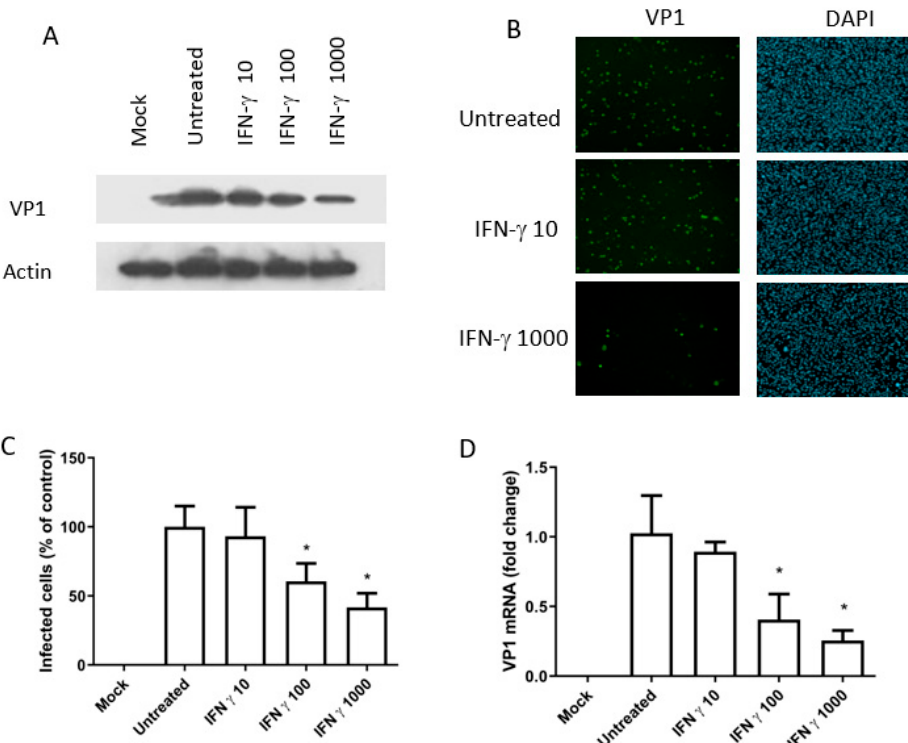
Figure 3. Interferon-gamma has dose-dependent activity against BKPyV in cultures of Caki-1 cells. Caki cells were treated 6 h before BKPyV infection (MOI: 0.5) with 10, 100 or 1000 IU / mL IFN-gamma ( A ) Total cellular proteins were extracted 72 h after infection. VP1 and actin were detected by Western blotting. ( B ) VP1 expression was analyzed using immunofluorescence. The cells were fixed three days post-infection and stained with monoclonal anti-BKPyV VP1 antibody (in green). The DNA was stained with DAPI (in blue). Magnification x400. ( C ) The percentage of infected cells was calculated from ( B ) by comparison with the DAPI staining. ( D ) mRNA levels of VP1 were measured using real-time quantitative RT-PCR and normalized against GAPDH . Each bar represents the average of three independent experiments analyzed in triplicate. “Mock” corresponds to non-infected cells and “Untreated” corresponds to cells infected in the absence of IFN. * p < 0.05.